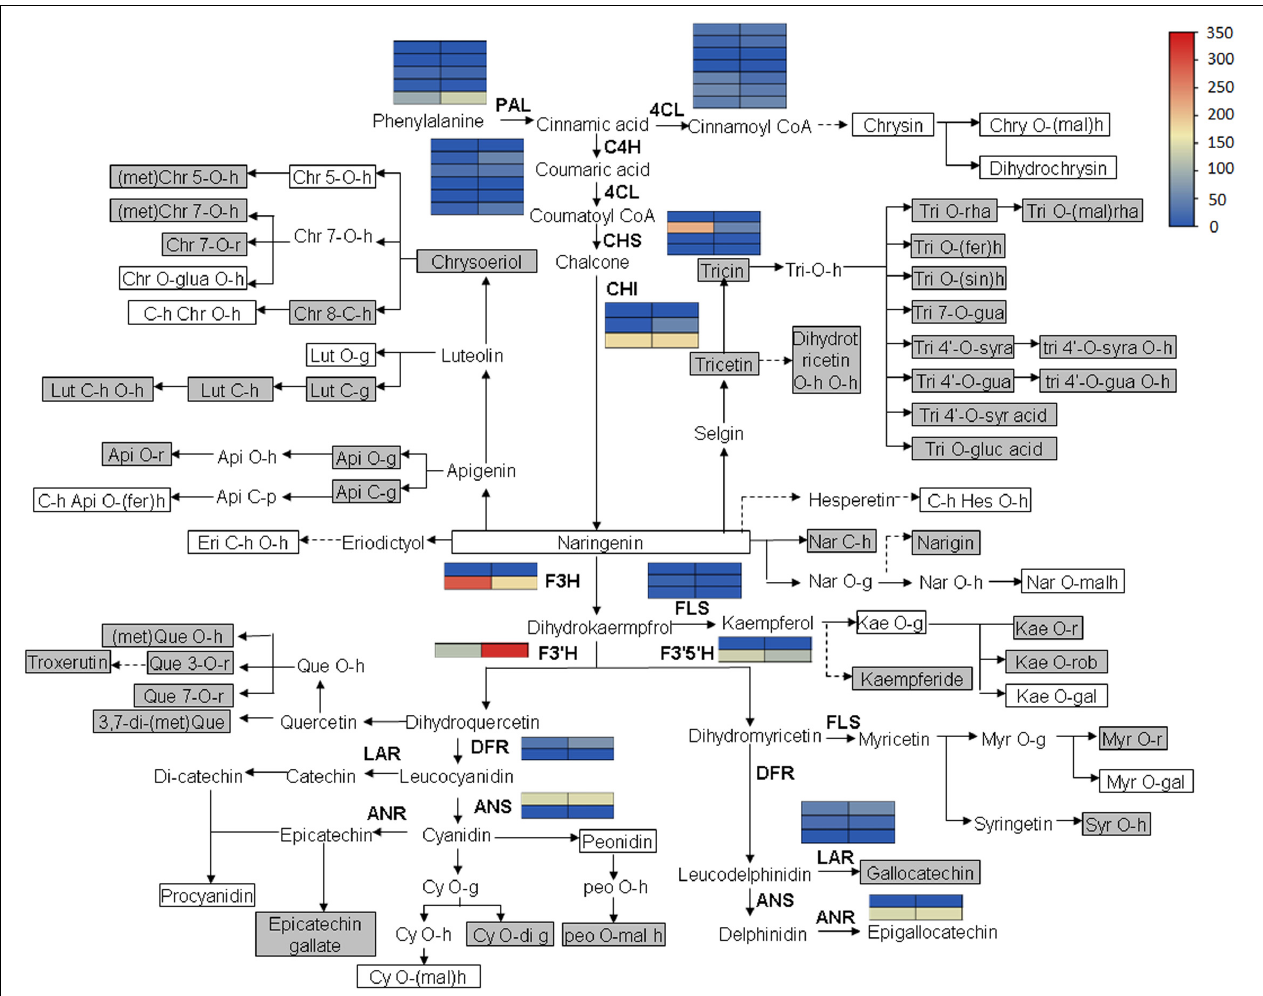
FIGURE 8 | Flavonoid biosynthesis and accumulation pathway in the leaves of Cyclocarya paliurus at low and high altitudes. The blue and red colors refer to the expression level of genes from low to high based on fragments per kilobase of exon per million fragments mapped (FPKM) value clustering. The gray box indicates significantly increased metabolites. The white box indicates significantly decreased metabolites. The metabolites without box indicate no significant change. Api, apigenin; Chr, chrysoeriol; Chry, Chrysin; Cy, cyaniding, Dp, delphinidin; Eri, Eriodictyol; fer, feruloyl; gal, galactoside; g, glucoside; gal, galactoside; glua, glucuronic acid; gua, guaiacylglycerol; h, hexoside/hexosyl; Hes, hesperetin; Kae, Kaempferol; Lut, Luteolin; mal, malonyl; met, methyl; Myr, Myricetin; Nar, Naringenin; Peo, Peonidin; Que, Quercetin; r, rutinoside; rha, rhamnoside; rob, robinobioside; rut, rutinoside; sin, sinapolyl; syr, syringic; syra, syringic alcohol; Tri, Tricin; PAL, phenylalanine ammonialyase; 4CL, 4-coumarate coenzyme A ligase; C4H, Cinnamate 4-hydroxylase; CHS, chalcone synthase; CHI, chalcone isomerase; F3H, flavanone 3-hydroxylase; FLS, flavonol synthase; F3 (cid:48) H, flavonoid 3 (cid:48) -hydroxylase; F3 (cid:48) 5 (cid:48) H, flavonoid 3 (cid:48) ,5 (cid:48) -hydroxylase; DFR, Dihydro flavonol reductase;